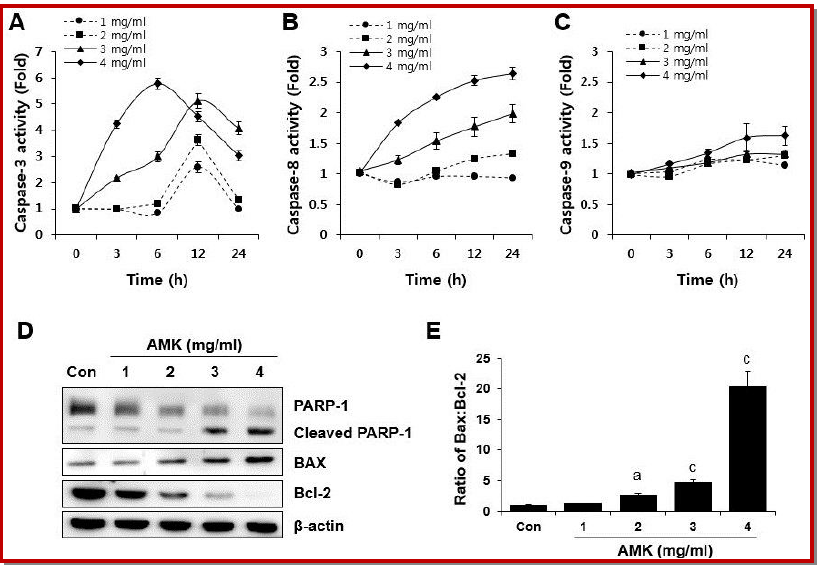
Figure 3: A. macrocephala (AMK)-induced extrinsic apoptosis pathway. (A-C) Caspase-3, 8 and 9 activity were measured by colori- metric protease assays following exposure of KB cells to A. macrocephala in a dose-dependent manner. (D) The protein levels of PARP-1, Bax, and Bcl-2. Equal protein loading was confirmed by the antibody reaction to β - actin. (E) The Bax:Bcl-2 radio was de- termined at the protein level. b p<0.001, and c p<0.0001 vs. non-treated